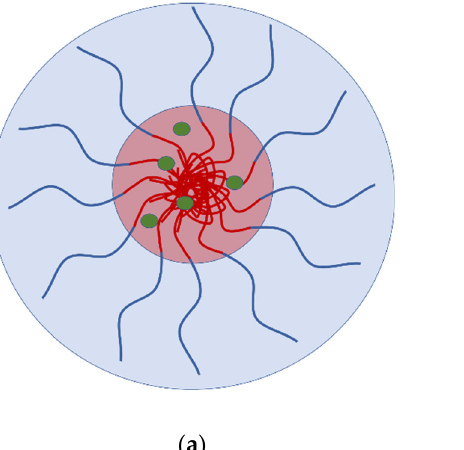
Scheme 2. ( a ) representative structure of AmB-loaded polymer micelles composed of PEG- b -PCL and ( b ) PEG-b-PCL-DSPE. In raw copolymers, hydrophobic PCL segment forming the nucleus was highly amorphous allowing for AmB dissolutions. Upon conjugation, PCL crystallized and AmB encapsulation was enabled by interactions with DSPE moiety.